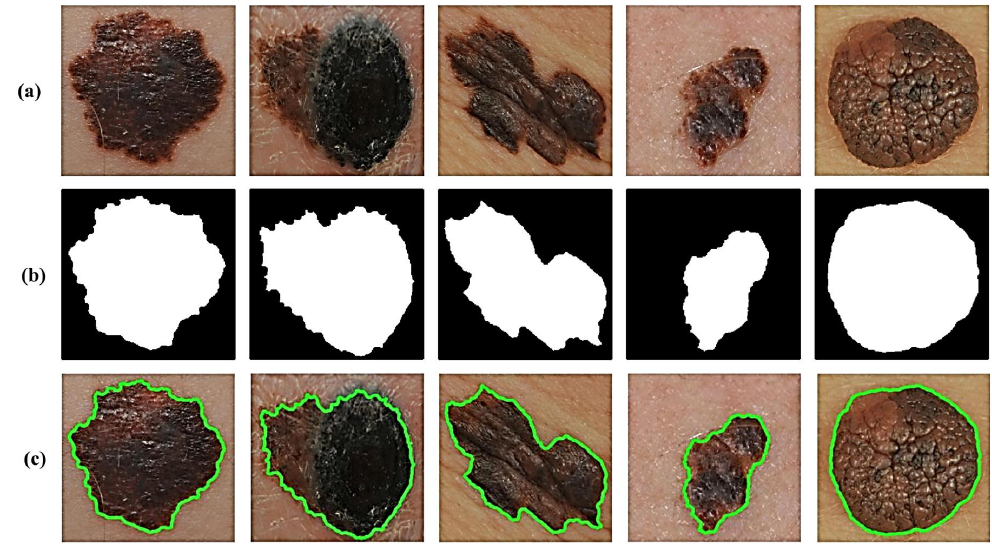
Figure 3. Results of lesion image segmentation: ( a ) Original image, ( b ) Binary Mask, and ( c ) Traced